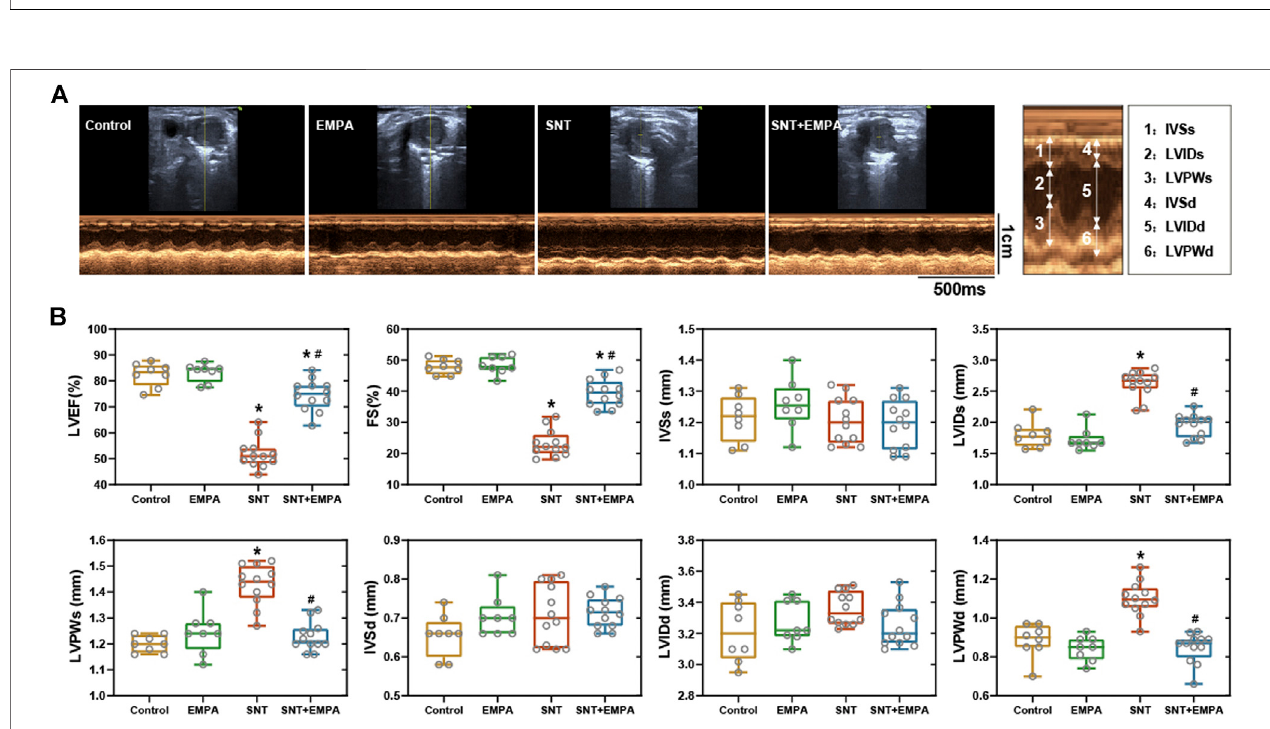
FIGURE 2 | Effects of EMPA on left ventricular systolic function in SNT-treated mice. (A) Representative recordings of M-mode echocardiography in a parasternal short axis view at the study endpoint among different groups, n (cid:1) 8 or 12 per group. (B) Left ventricular systolic function parameters evaluated from M-mode images at the study endpoint among different groups, n (cid:1) 8 or 12 per group. * p < 0.05 vs. control, # p < 0.05 vs. SNT.